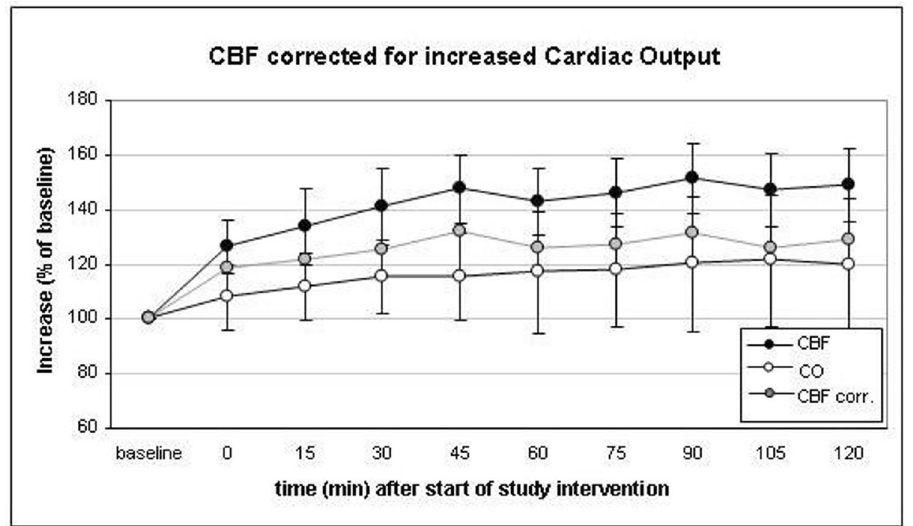
Figure 6. Time course of cerebral blood flow (CBF, black dots), cardiac output (CO, white dots) and CBF corrected for CO (grey dots). The correction subtracts the increase of CO from the increase of CBF in order to calculate the intrinsic CBF-increasing effect of the study intervention in the cerebral vasculature. The peak increase was noted after 45 min. Data presented as Mean ± SD; 1-way ANOVA for Repeated Measurements; *p < 0.05, **p < 0.01, ***p < 0.001, plots and error bars presented as Mean ± SD (standard